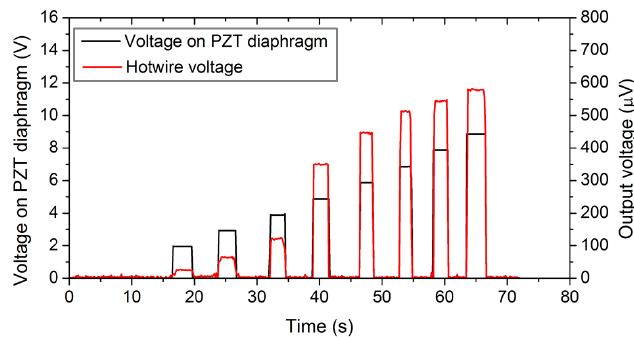
Figure 8. Change in hotwire voltage with increasing pump voltage.